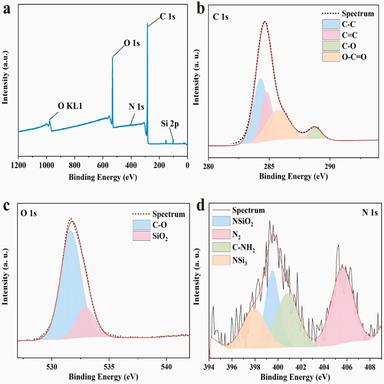
The elemental analysis of SPCM. (a) Overall XPS spectrum, (b) C 1 s, (c) O 1 s, (d) N 1 s.